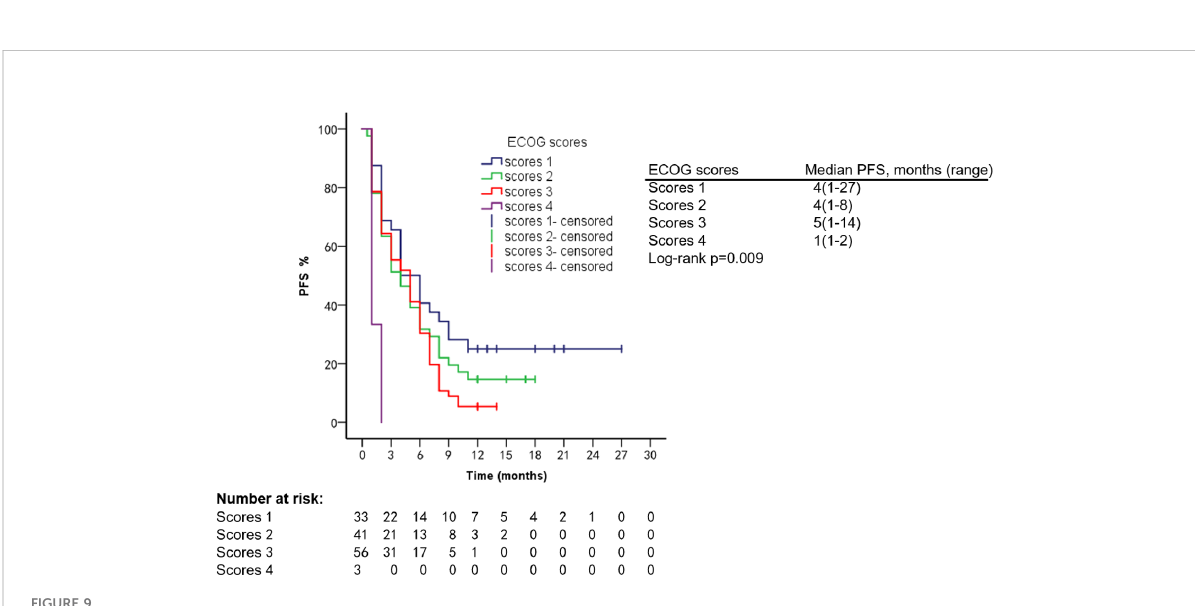
FIGURE 9 PFS of patients with different ECOG